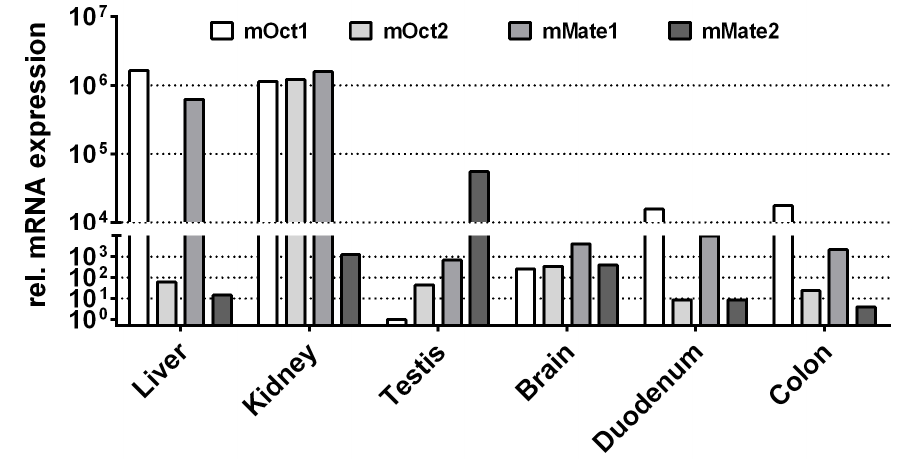
Figure 3. mRNA expression pattern of mOct1, mOct2, mMate1, and mMate2 in liver, kidney, testis, brain, duodenum, and colon of the mouse. The mRNA expression was analyzed by quantitative real-time PCR analysis using cDNAs from the indicated tissues of a male C57BL/6N mouse. Relative carrier expression was calculated by the 2 −ΔΔ CT method and represents carrier expression that is x times higher compared with the overall lowest expression (i.e., mOct1 testis, set as calibrator). Values represent means of duplicate determinations.